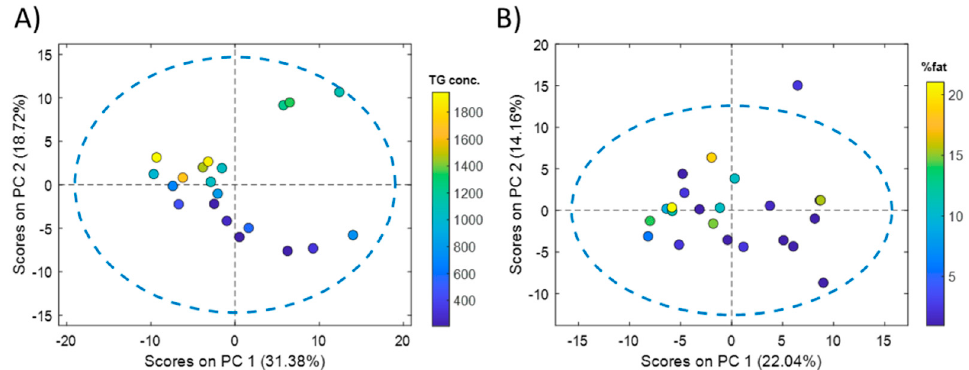
Figure 1. PCA of liver and serum miRNA profiles. PCA scores calculated from the analysis of human liver tissue ( A ) and serum ( B ) miRNA profiles. Color scales in the score plots indicate the reference liver TG concentration ( µ g TG/mg protein) ( A ) or the % of fat quantified in hematoxylin- eosin stained liver biopsies ( B ).